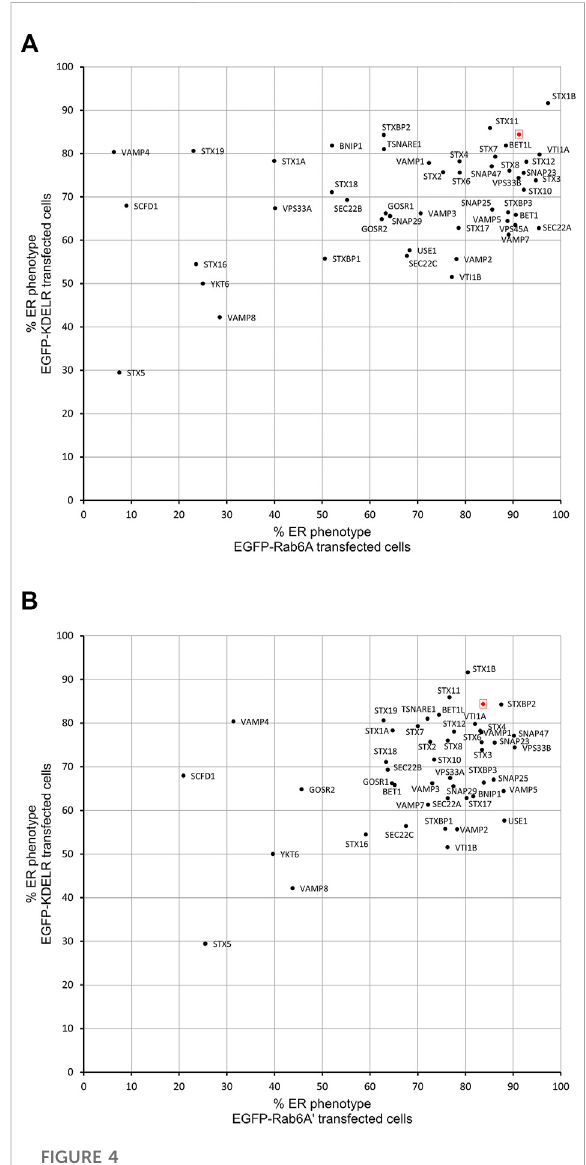
FIGURE 4 Comparison of Golgi redistribution assays. (A) Scatterplot showing the percentage of ER phenotypes in the population after depletionofeachSNAREorSNARE-likeproteinandBFAtreatment in EGFP-Rab6A and EGFP-KDELR expressing cells. The x-axis represents the percentage of ER phenotypes resulting from each depletion in EGFP-Rab6A transfected cells, and the y-axis represents the percentage of ER phenotypes resulting from each depletion in EGFP-KDELR transfected cells. The highlighted red dot represents the result from negative (NEG) control transfected cells. Pearson ’ s coef fi cient is 0.4. (B) Scatterplot showing the percentage of ER phenotypes in the population after depletion of each SNARE or SNARE-like protein and BFA treatment in EGFP- Rab6A ′ and EGFP-KDELR expressing cells. The x-axis represents the percentage of ER phenotypes resulting from each depletion in EGFP-Rab6A ′ transfected cells, and the y-axis represents the percentage of ER phenotypes resulting from each depletion in EGFP-KDELR transfected cells. The highlighted red dot represents the result from negative (NEG) control transfected cells. Pearson ’ s coef fi cient is